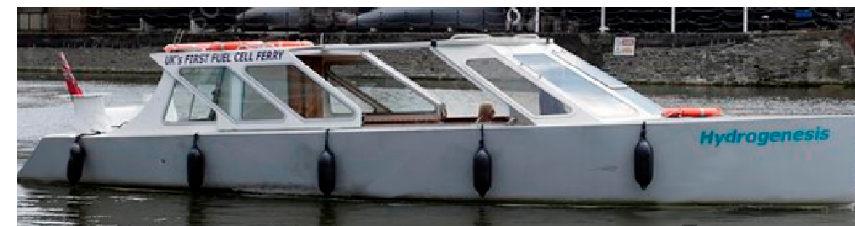
Figure 41. The fuel cell ferryboat “Hydrogenesis” [186].